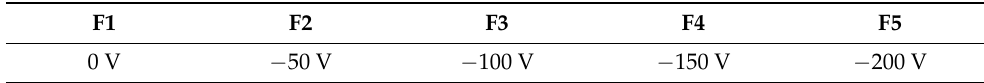
Table 2. The experimental